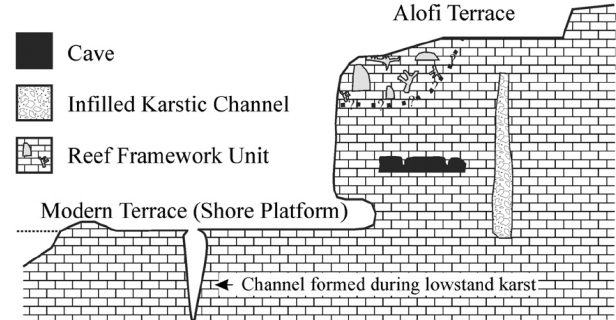
Figure 22. A schematic cross section showing the stratigraphic re- lationships between the Pleistocene and modern terrace on Niue. Reef framework is not ubiquitous along the Alofi Terrace edge (from Kennedy et al.,